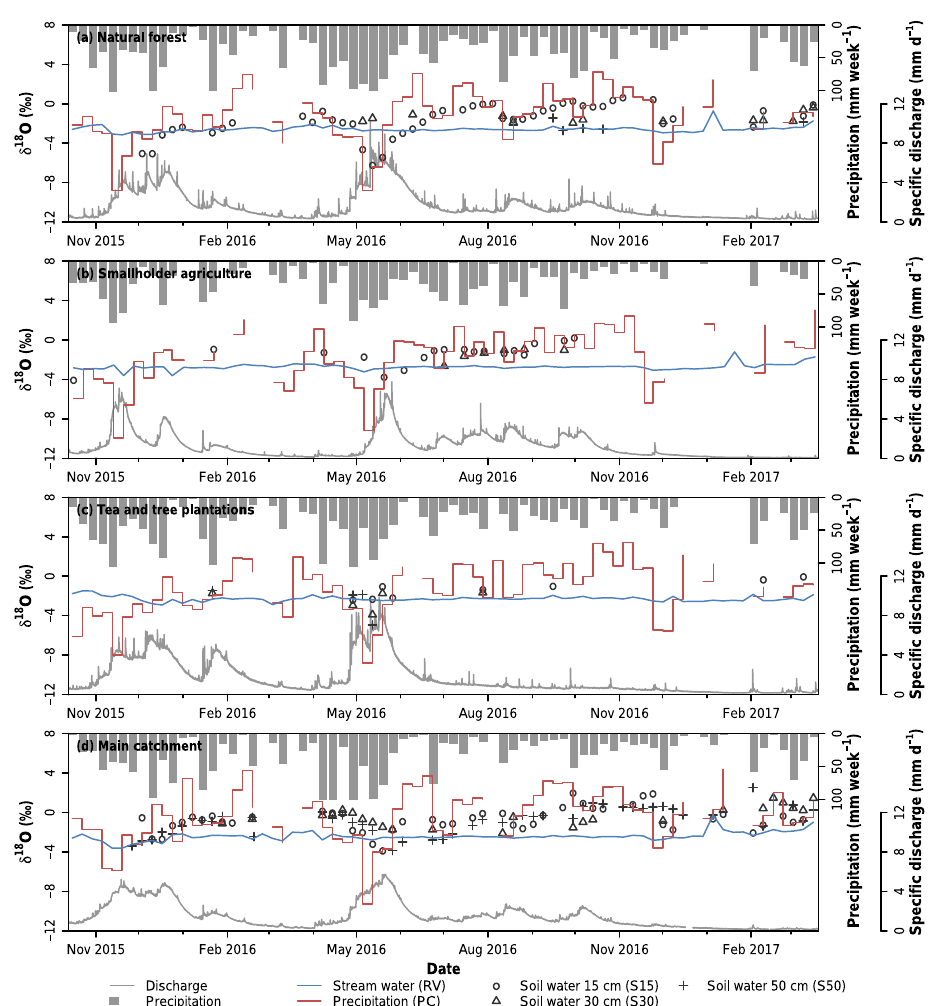
Figure 3. Time series of δ 18 O values in precipitation (PC), stream water (RV) and mobile soil water at 15, 30 and 50cm depth (S15, S30 and S50, respectively); specific discharge and weekly precipitation in the (a) natural forest (NF), (b) smallholder agriculture (SHA), and (c) tea and tree plantations (TTP) sub-catchments, and (d) the main catchment (OUT) between 15 October 2015 and 17 March 2017 in the South-West Mau,